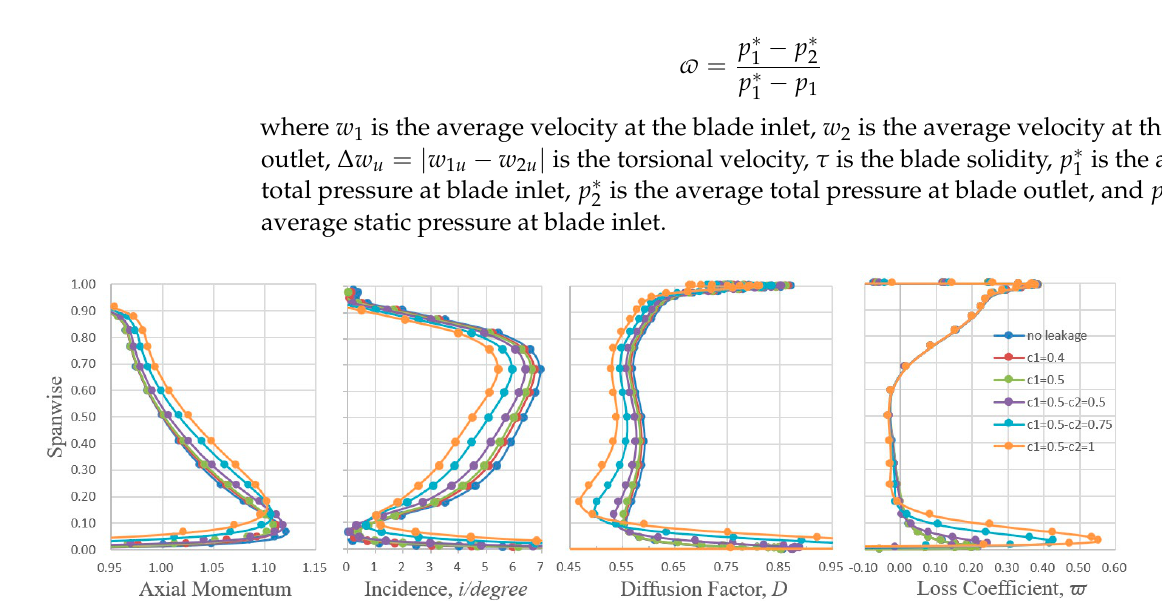
Figure 15. Spanwise distribution of blade element performance for Rotor 2.